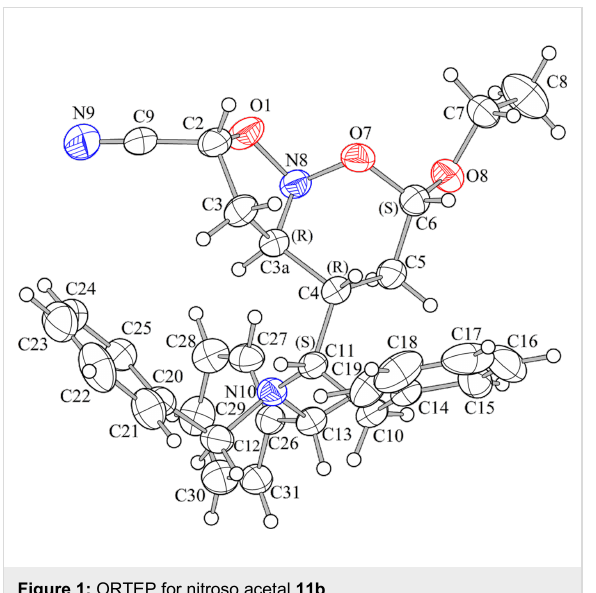
Figure 1: ORTEP for nitroso acetal 11b .